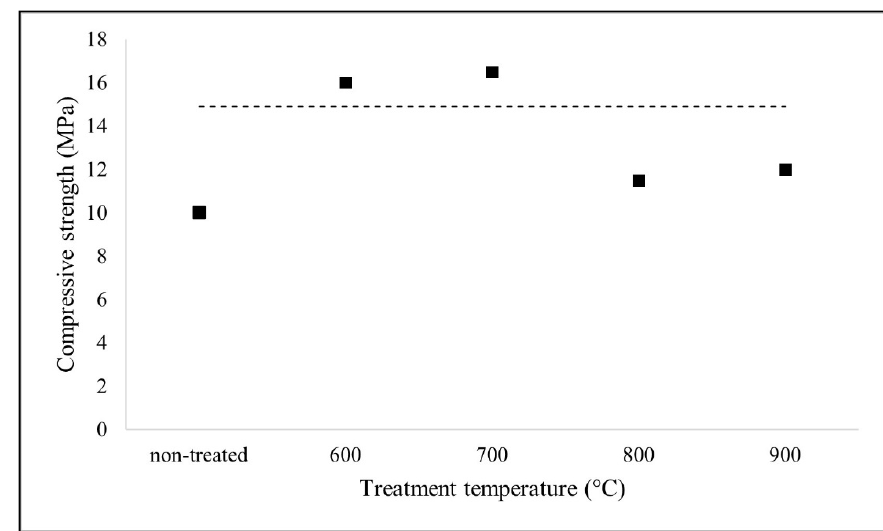
Figure 5. Effect of the chemical treatment of MSWI-BA on the compressive strength of concrete at 28 days, redrawn from [37].